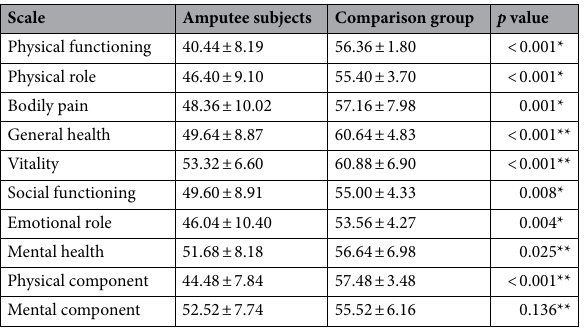
Table 1. Data associated with Questionnaire SF36 (mean ± SD). *Mann–Whitney U Test. **Student’s T